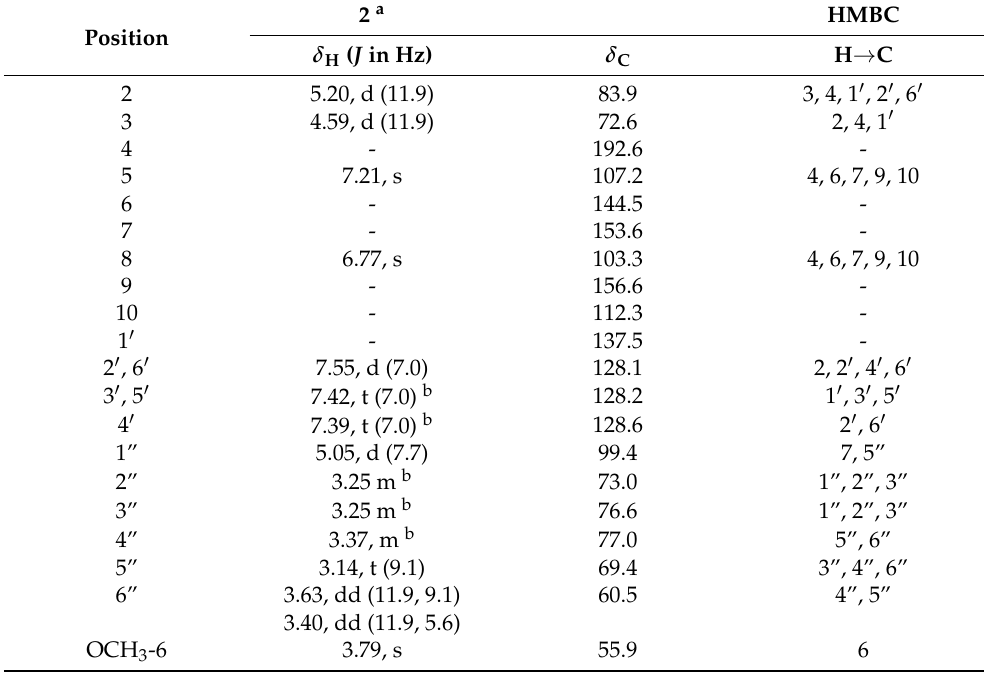
Table 1. 1 H (700 MHz) and 13 C NMR (175 MHz) data of 2 a